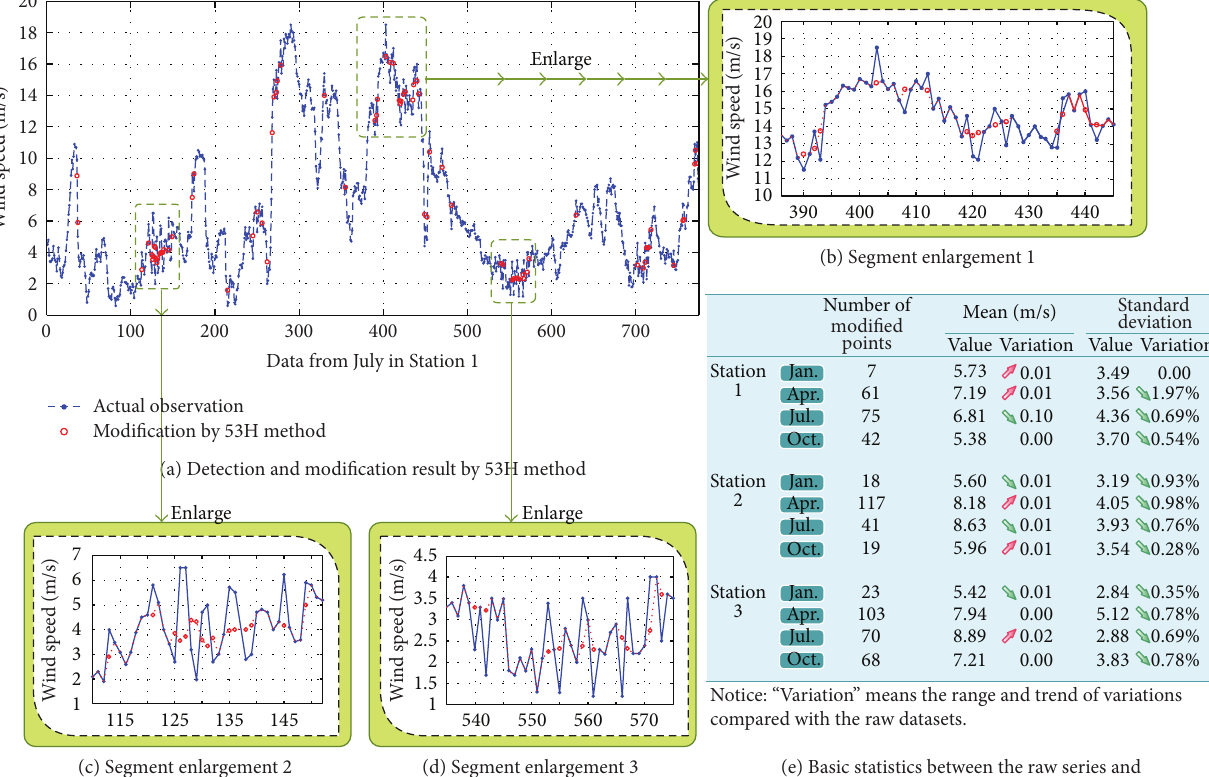
“Variation” means the range and trend of variations compared with the raw datasets. (e) Basic statistics between the raw series and 53H-modified